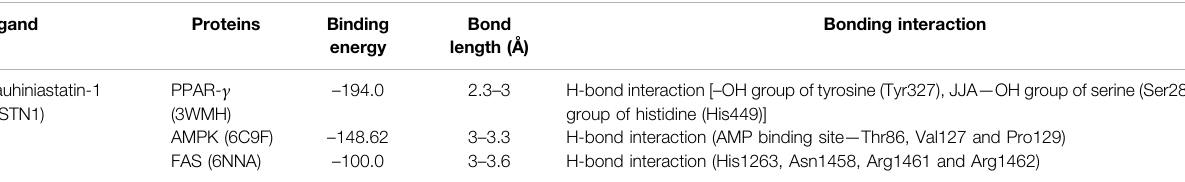
TABLE 5 | Molecular docking of BSTN1 (11687814) depicting ligand-protein binding interactions. Ligand